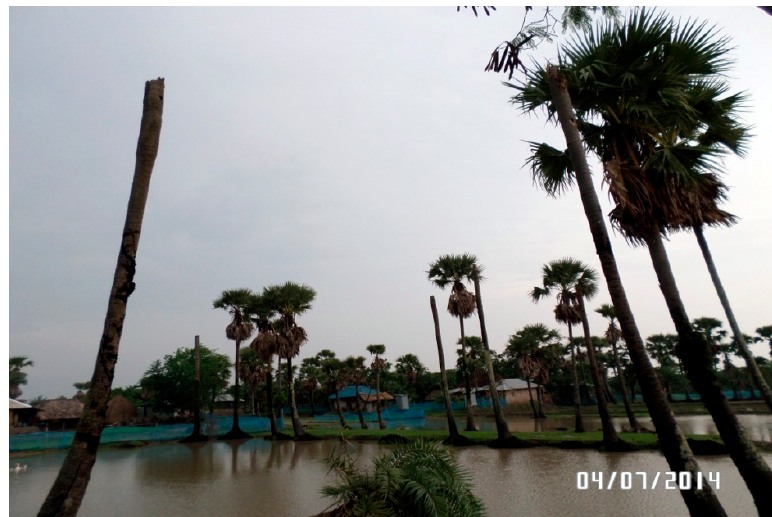
Figure 1. Marker of climate change: Trees die after salinity ingress in Koyra. Source: Field data.